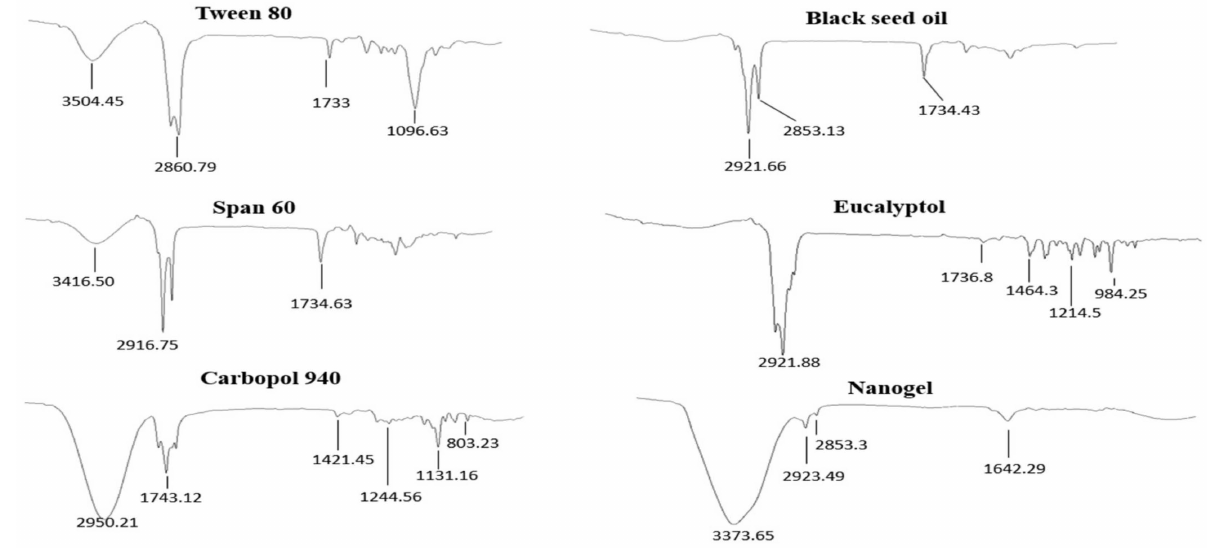
Figure 3. FTIR spectrum of all excipients used and the optimized F5